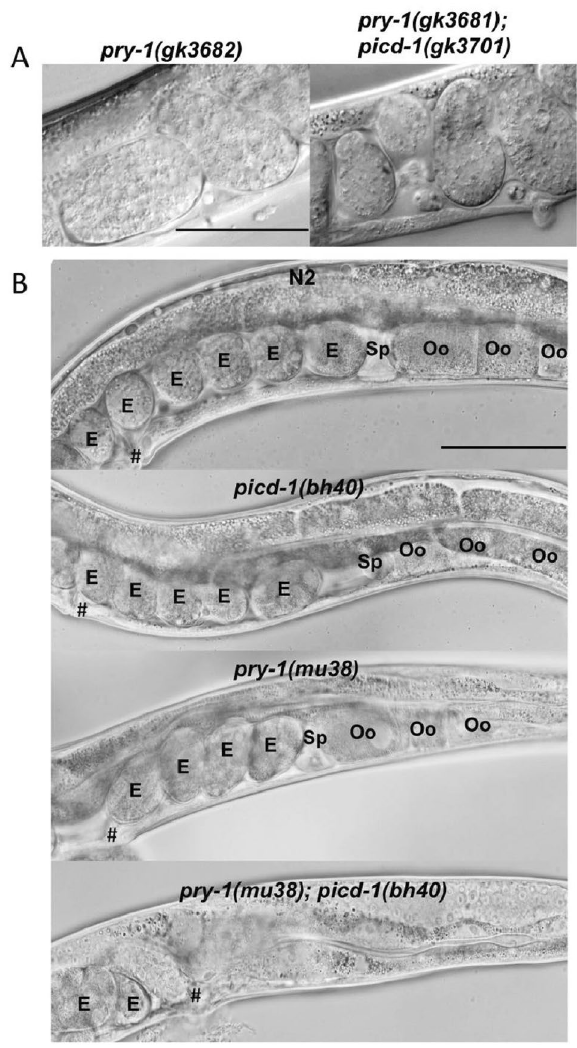
Figure 7. picd-1 interacts with pry-1 to regulate oocyte development. ( A ) pry-1; picd-1 double mutants show abnormal oocytes. Scale bar is 25 µm. ( B ) Posterior gonad arms of wildtype, picd-1(bh40), pry-1(mu38) and pry-1(mu38); picd-1(bh40) adults. pry-1(mu38); picd-1(bh40) animals frequently lack oocytes (46 ± 6%, n = 45, p < 0.01) in the posterior gonad arm when compared to N2 and pry-1(mu38) . Statistical analysis was done using an unpaired t-test. The spermatheca (Sp), embryos (E), and oocytes (Oo) are marked. Vulva opening is marked (#). Anterior is on the left. Scale bar is 100